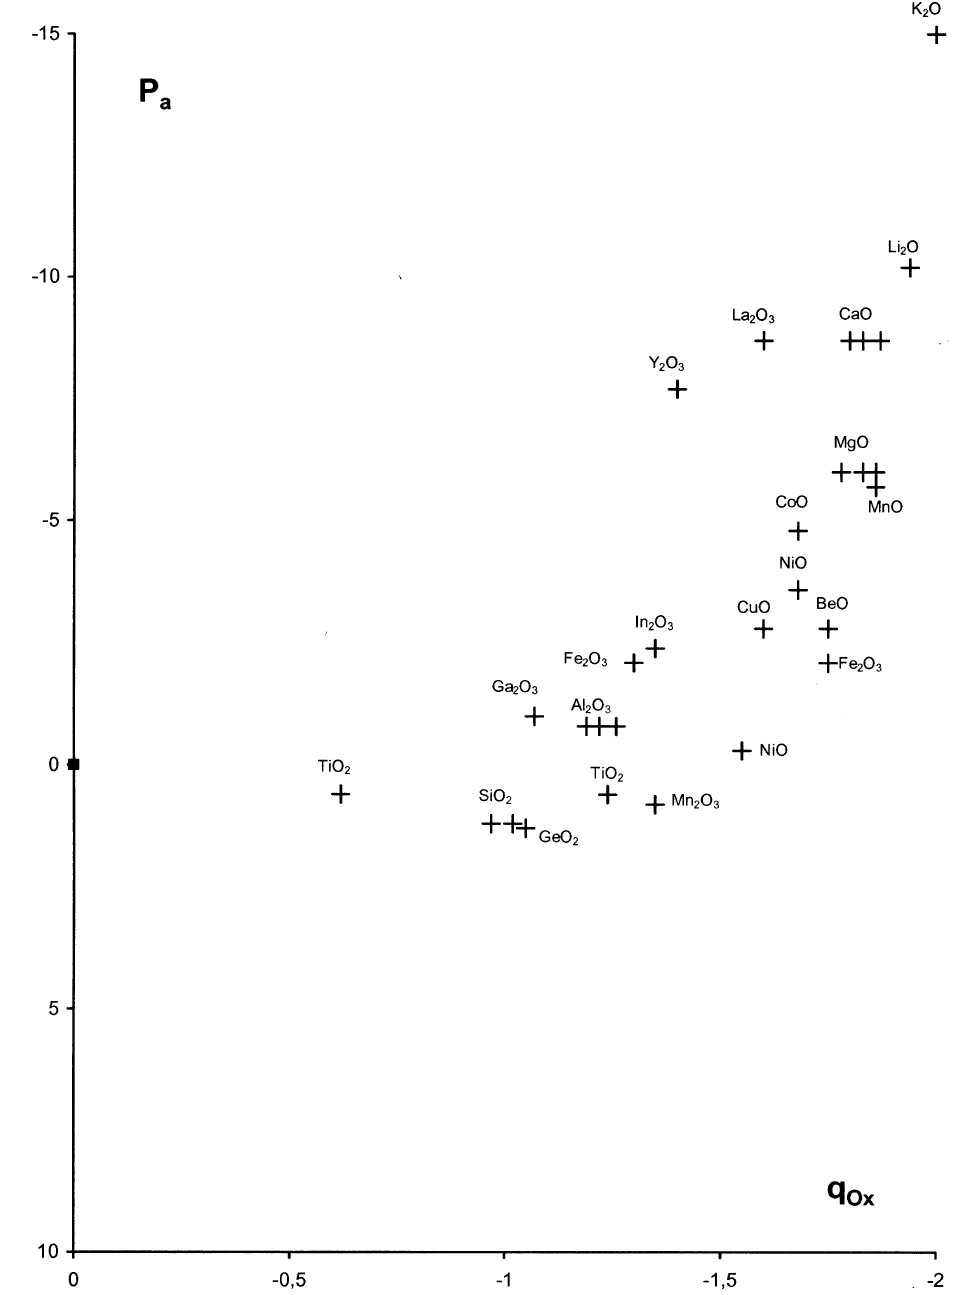
FIGURE 8 Plot of P a vs. calculated ionic charges q Ox